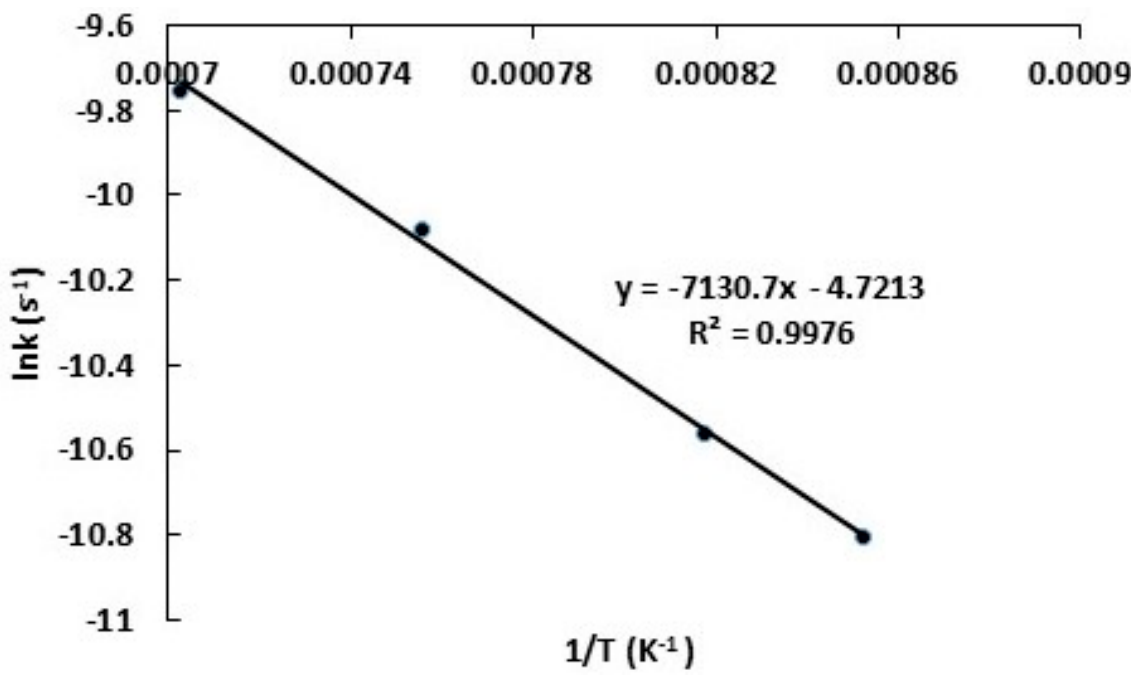
Arrhenius plot for barium sulfate conversion created using the calculated rate con- stants (Figure 8).